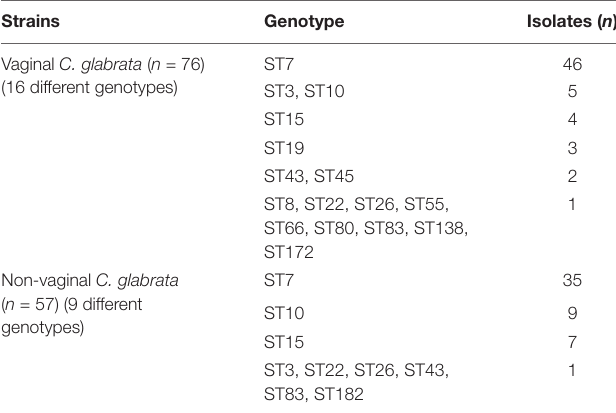
TABLE 3 | Summary of multilocus sequence typing genotypes for the 76 vaginal and 57 non-vaginal C. glabrata isolates.